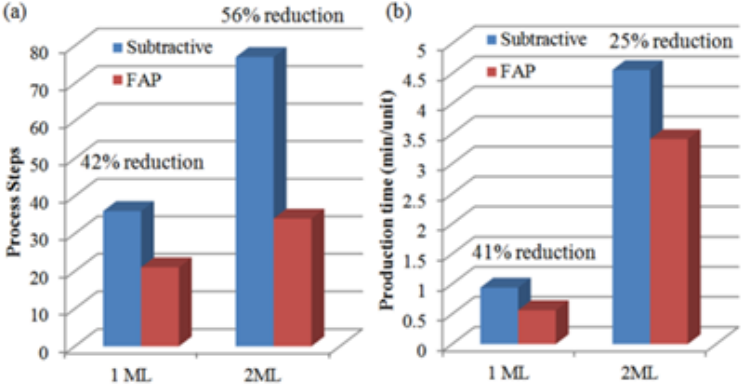
Figure 6. (a) Process steps reduction; (b) Production time reduction with the proposed development technology as compared to conventional